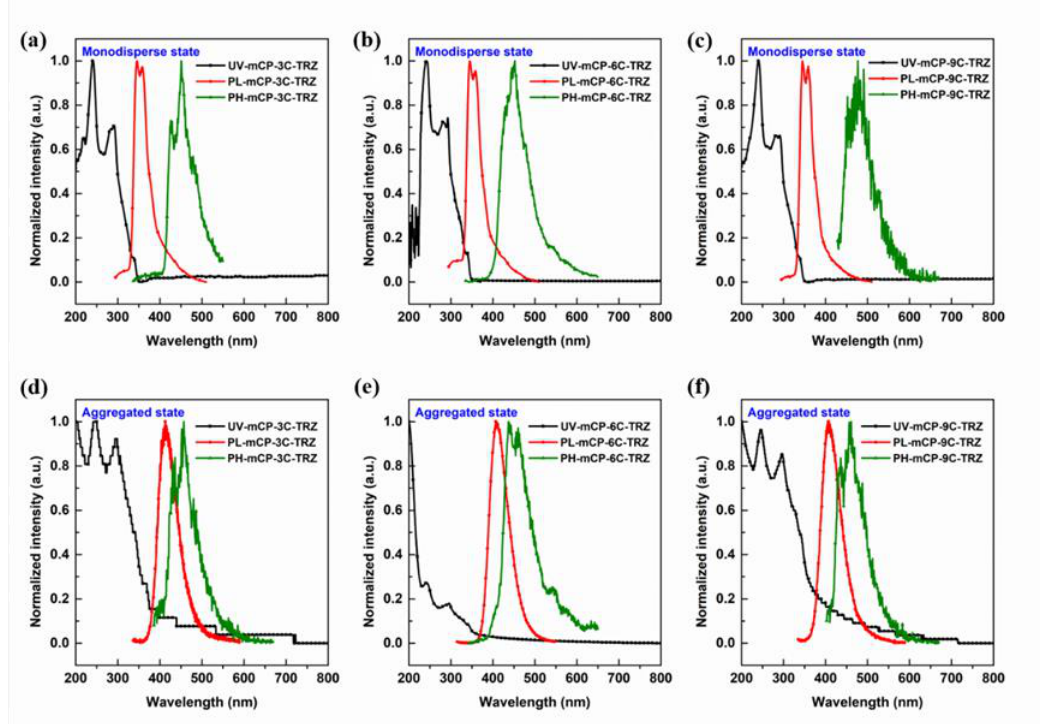
Figure 4. Normalized absorption spectra, fluorescence spectra and low-temperature phosphorescence spectra (after delay 100 μs) of mCP -3C-TRZ, mCP-6C-TRZ and mCP-9C-TRZ in toluene ( a – c ) and in solid-state film ( d – f ).